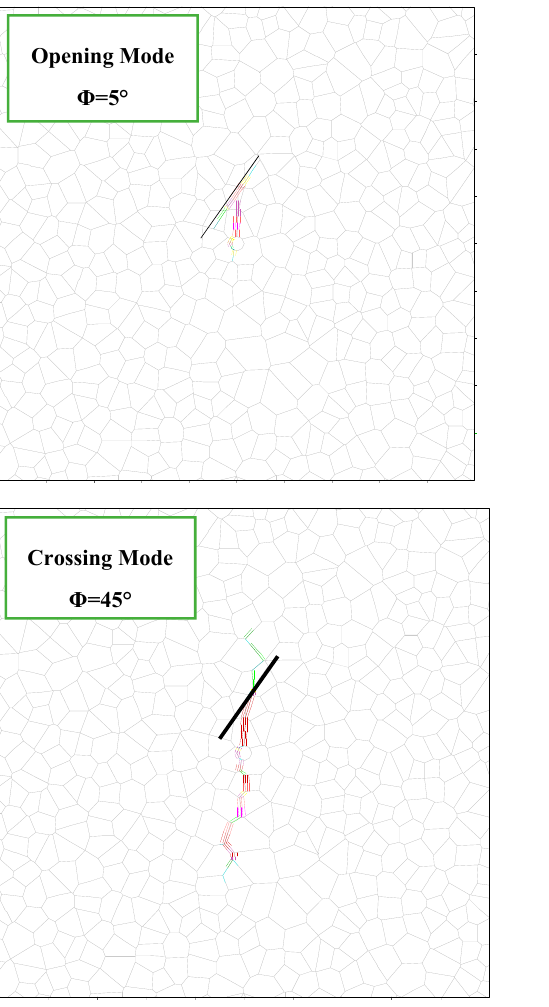
Figure 10. Effect of cohesion strength of NF on the HF propagation (approach angle of 33 degrees and 232 Δσ of 10 MPa) 233